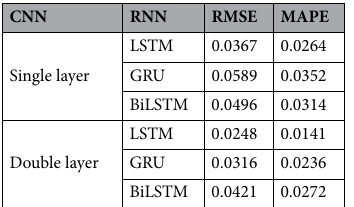
Table 4. CNN and RNN compared the experimental prediction results.